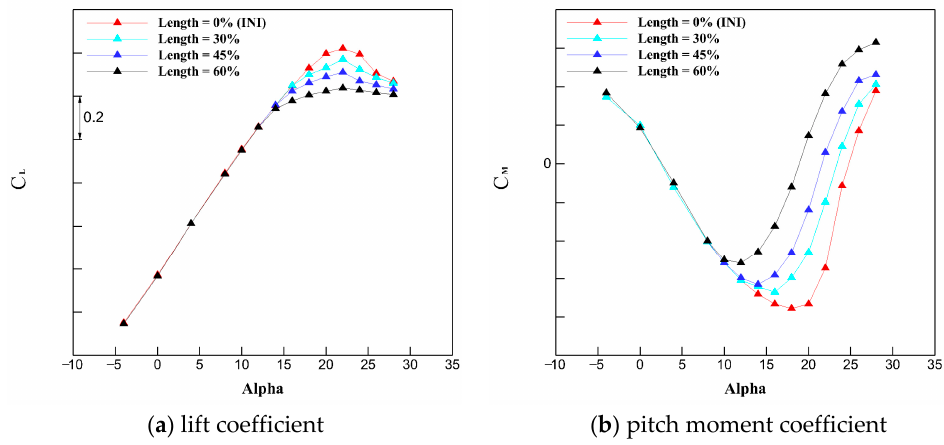
Figure 18. Aerodynamic coefficient of the sensitivity analysis of Length.